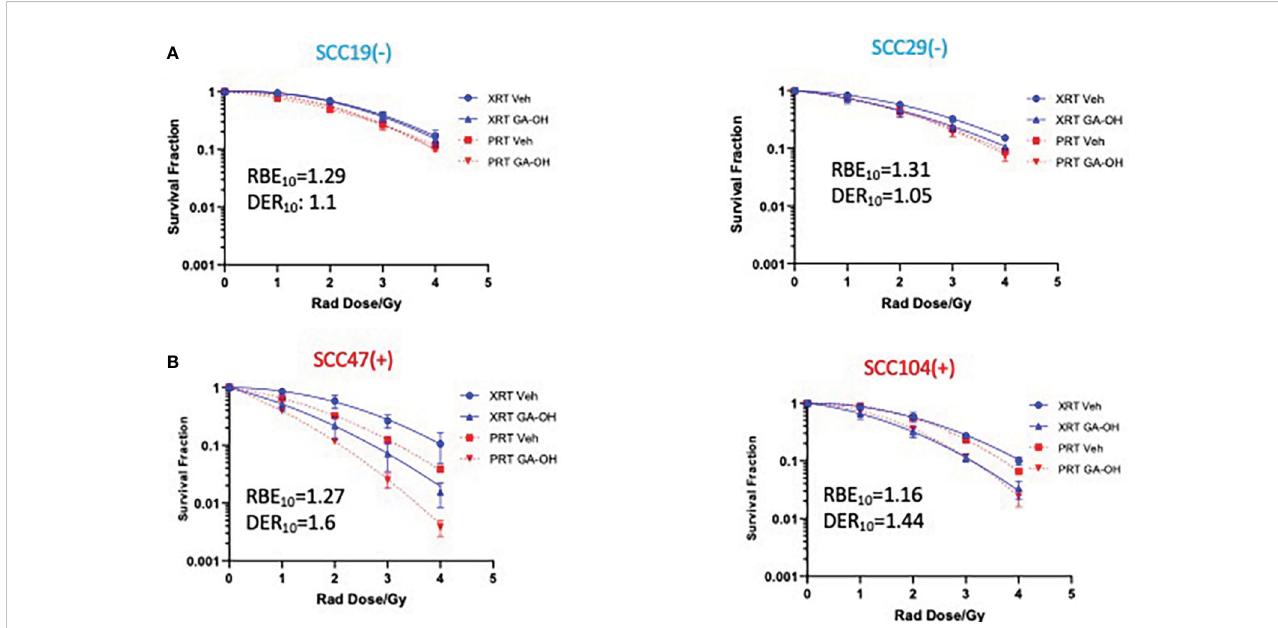
FIGURE 4 Sensitization of HNSCC cells to X-ray versus proton radiation combined with GA-OH. HPV - (-) and HPV + (+) cells were treated with GA-OH (see table S1 for concentrations) in combination with X-ray radiation or protons (0-4Gy)). Colonies were counted after 14-21 days of incubation and normalized to controls and survival analysis was performed using the linear quadratic model and GraphPad. Relative effectiveness of protons compared to X-ray (photons) with and without GA-OH by way of RBE 10 calculations in HPV - (A) and HPV + (B) cells. Values shown represent means ± standard deviation from 3 independent